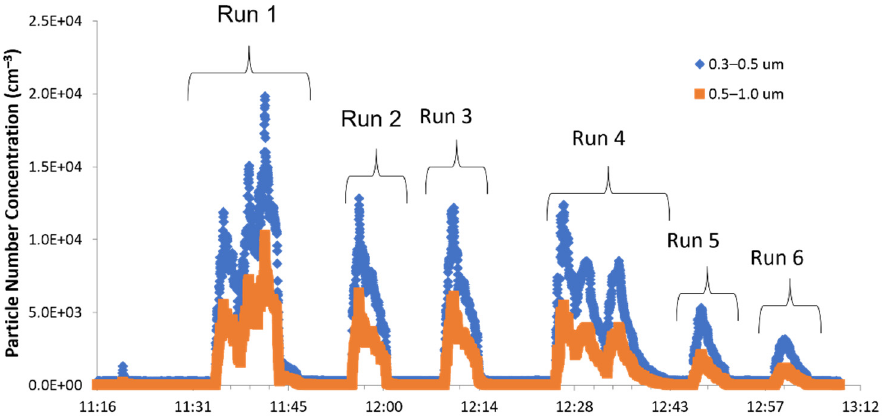
Figure 3. Temporal trend of the particle number concentrations inside the spray cham- ber.